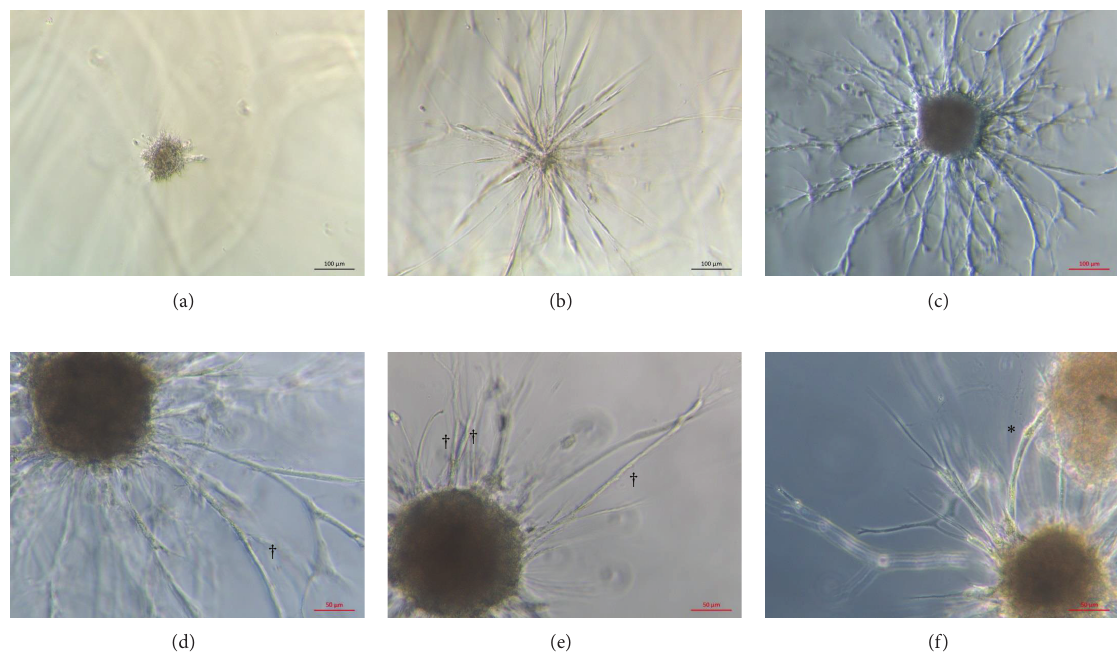
Figure6:NeonatalsbMSCscooperatewithHUVECsinspheroidstoformacomplexsproutingnetworkinfibringel.(a)Spheroidscontaining HUVECs (400 cells/spheroid) manifested minimal sprouting at 6 days. (b) Spheroids containing sbMSCs (400 cells/spheroid) had manifested increased sprouting after 6 days. (c) Spheroids containing HUVECs and sbMSCs (800 cells/spheroid with 1: 1 ratio of each cell type) demonstrated a complex sprouting network at 6 days. Scale bar = 100 𝜇 m. (d and e) Tube formation ( † ) was evident in a subset of sprouts emanating from spheroids. Scale bar = 50 𝜇 m. (f) Adjacent spheroids were sometimes connected to each other by anastomosing sprouts ( ∗ ). Scale bar = 20 𝜇